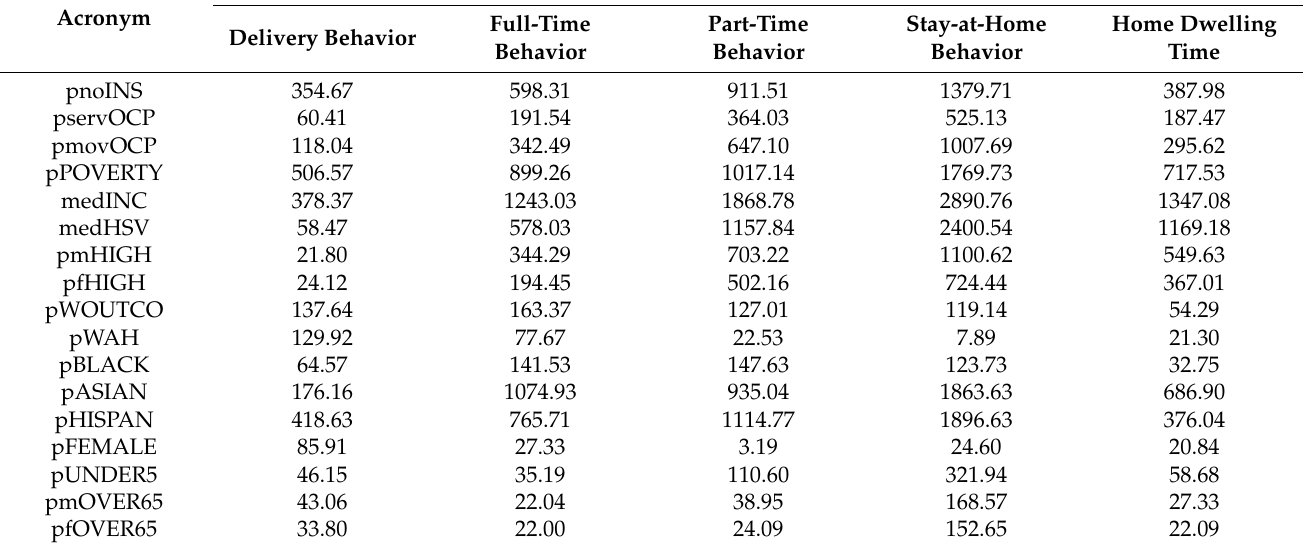
Table 2. ANOVA test results for the socioeconomic and demographic variables and the five social mobility groups 1